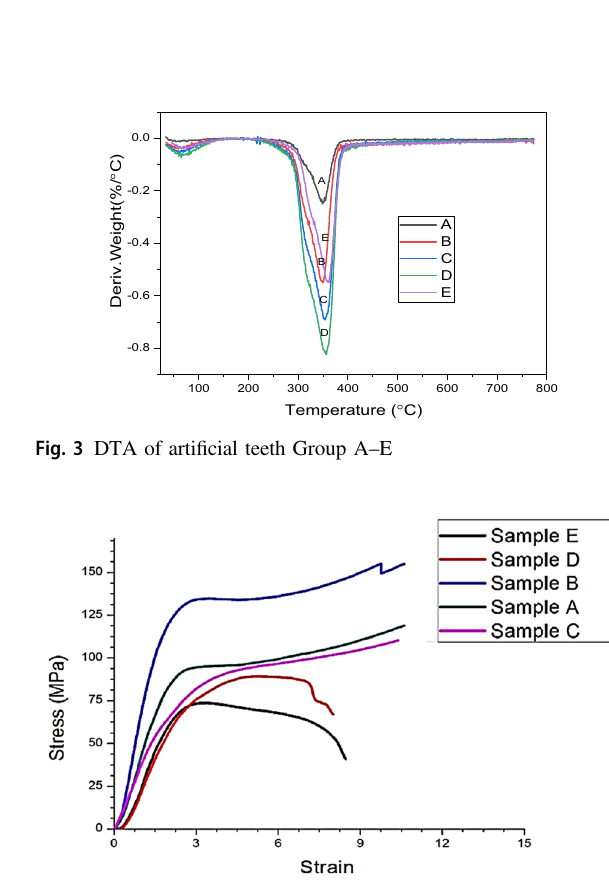
Fig. 4 The typical stress-strain curves and values of ultimate com- pressive strength of the arti fi cial teeth